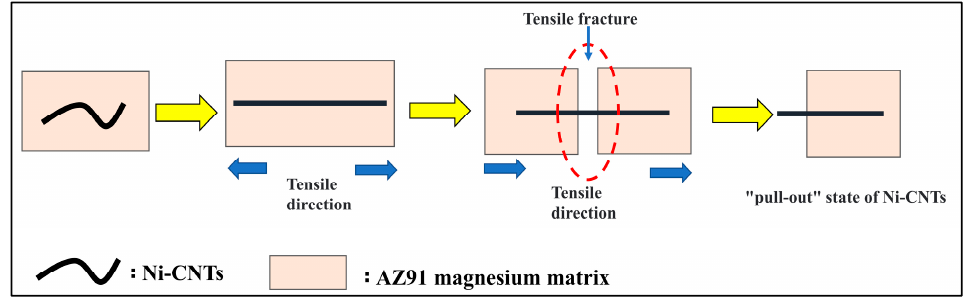
Figure 12. Schematic diagram of the tensile process of Ni-CNTs/AZ91 magnesium matrix composites.